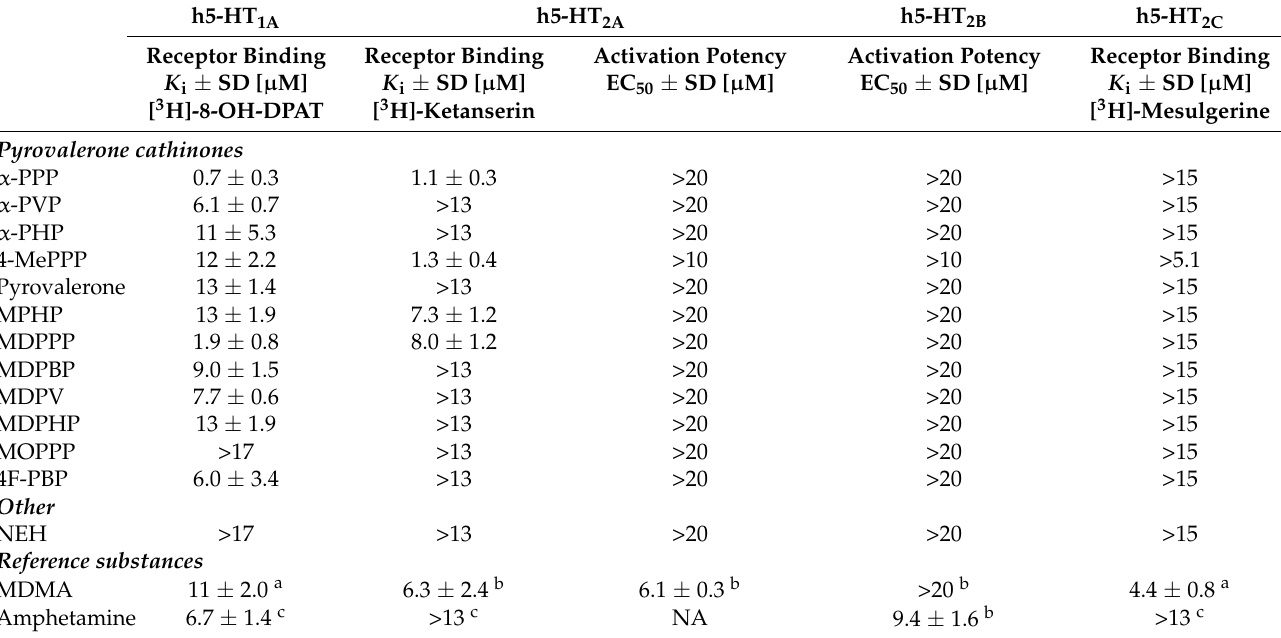
Table 2. Serotonin receptor binding affinities and activation potencies of pyrovalerone and